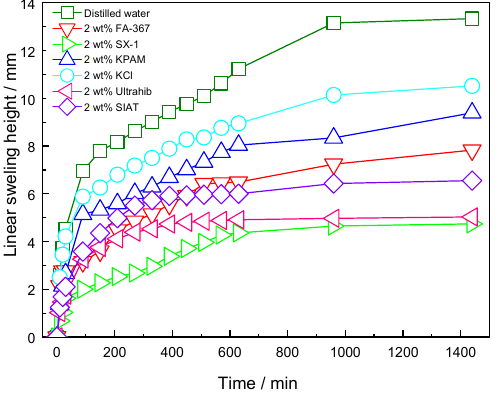
Figure 7. Linear swelling tests of Na-MMT artificial core in different inhibitor solutions.